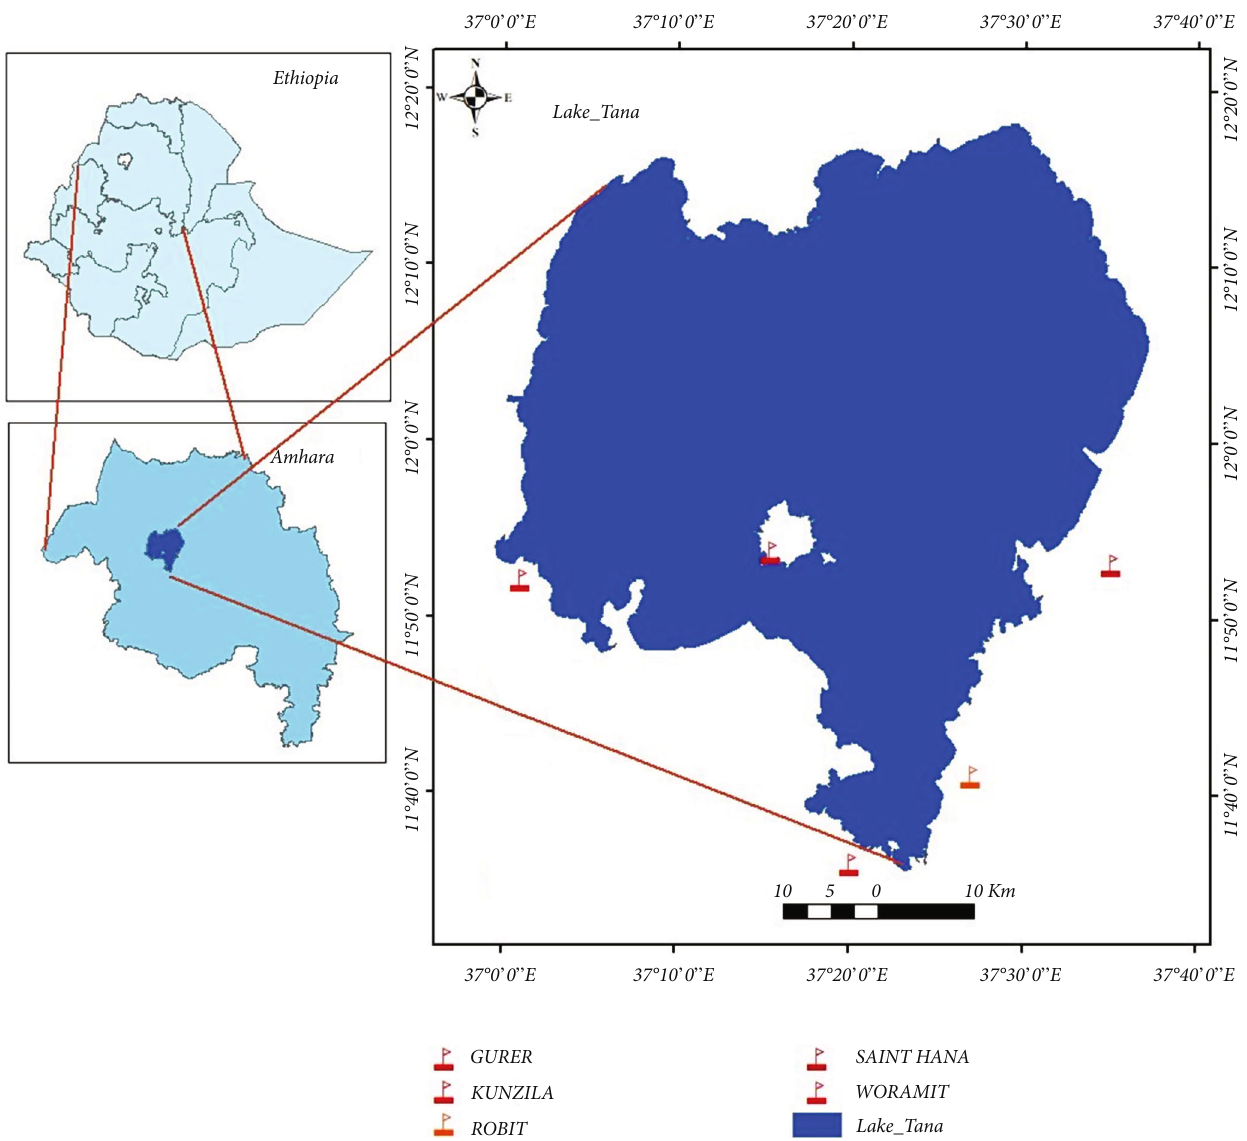
Figure 1: Map of the study area showing all selected primary schools around Lake Tana. The map was prepared using the ArcGIS online